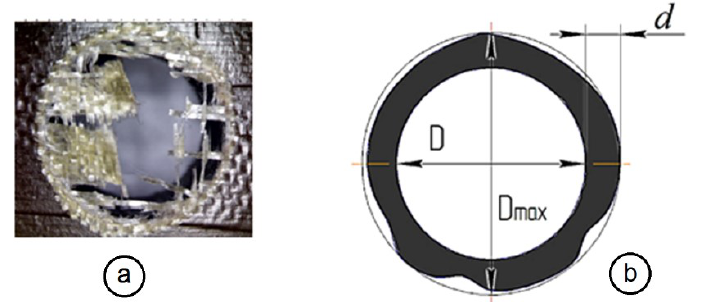
Figure 3. Evaluation of delamination at the entry and exit of the drill from the hole: ( a ) a shot of the exit point of the drill from the hole; ( b ) delamination measurement